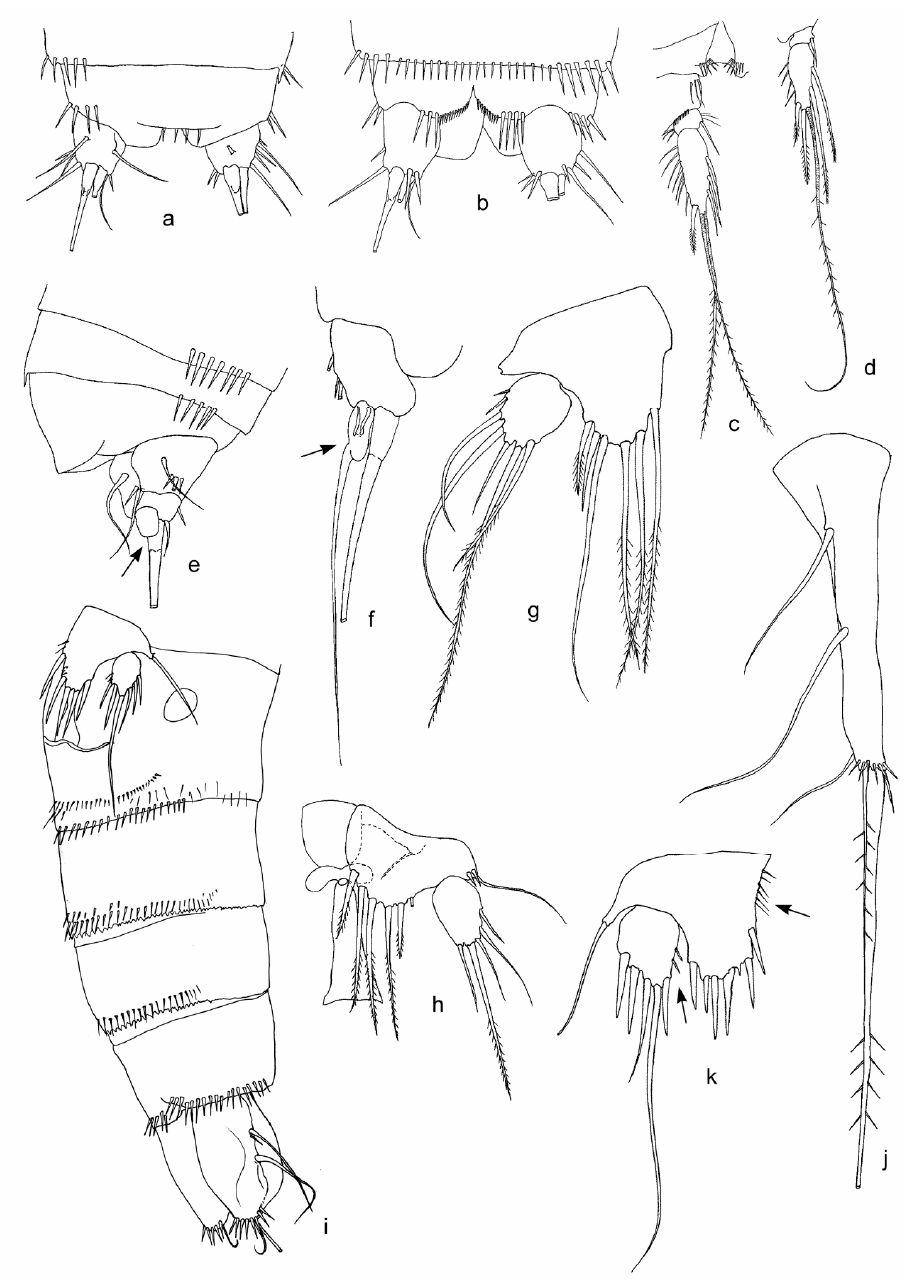
Figure 4. Features of females of Bryocamptus sp. 5 ( a – d ), B. sp. 6 ( e – g ), B. sp. 7 ( h ), Moraria sp. 2 ( i ), and M. cf. sinuata ( j , k ) from Lake Baikal sites: Fr ( a – g ), K2 ( h ), SPb ( i ), and GU ( j , k ). ( a )—furca, dorsal view; ( b )—furca, ventral view; ( c )—P3 endopod; ( d ) — P4 endopod; ( e ) — anal somite, dorso–ventral view; ( f ) — caudal ramus, ventral view; ( g , h , k )—P5; ( i )—abdomen, dorso–ventral view; and ( j )—caudal ramus, dorso–ventral view. Abbreviations in Table 1. Some features are shown by arrows. Subgenus Rheocamptus Borutzky,